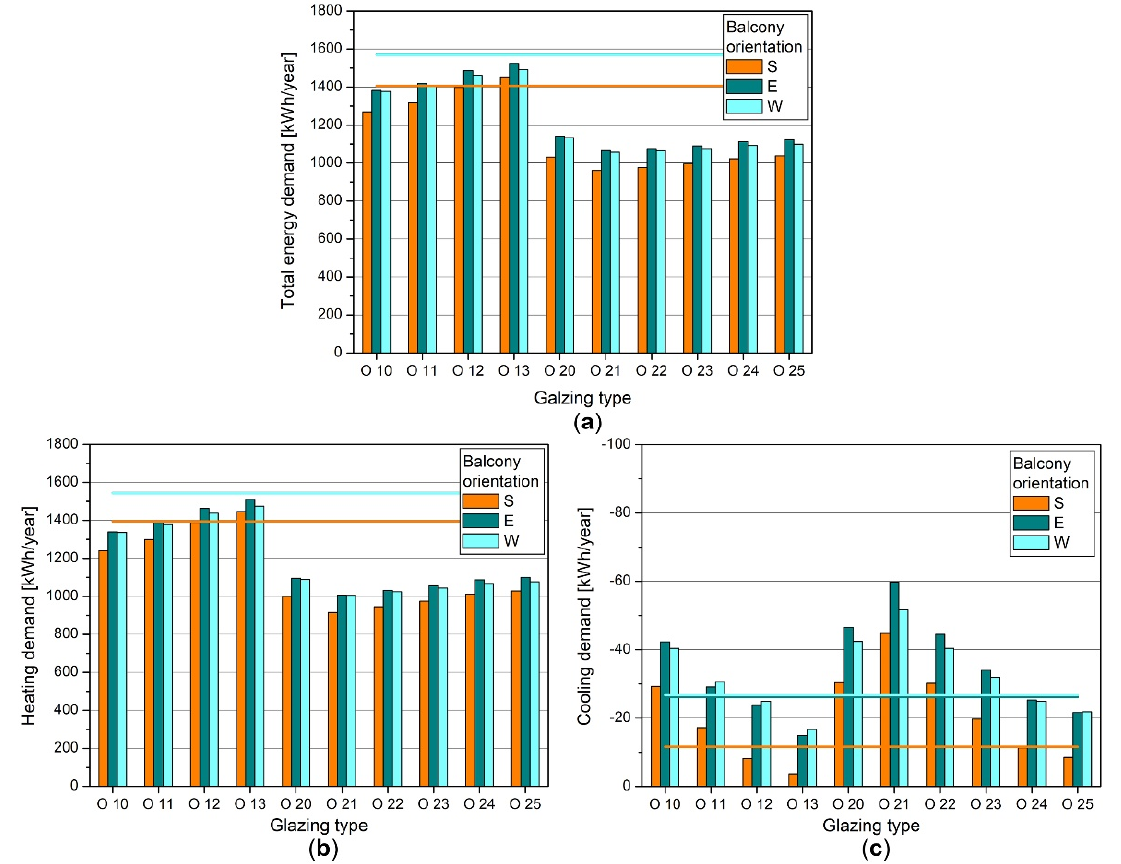
Figure 9. Energy demand in the flat, glazing height 2.20 m: ( a ) total energy demand; ( b ) heating demand; ( c ) cooling demand. Bars depict energy demand in the apartments with glazed balconies, lines—in the apartment with an open bal ‐ cony.